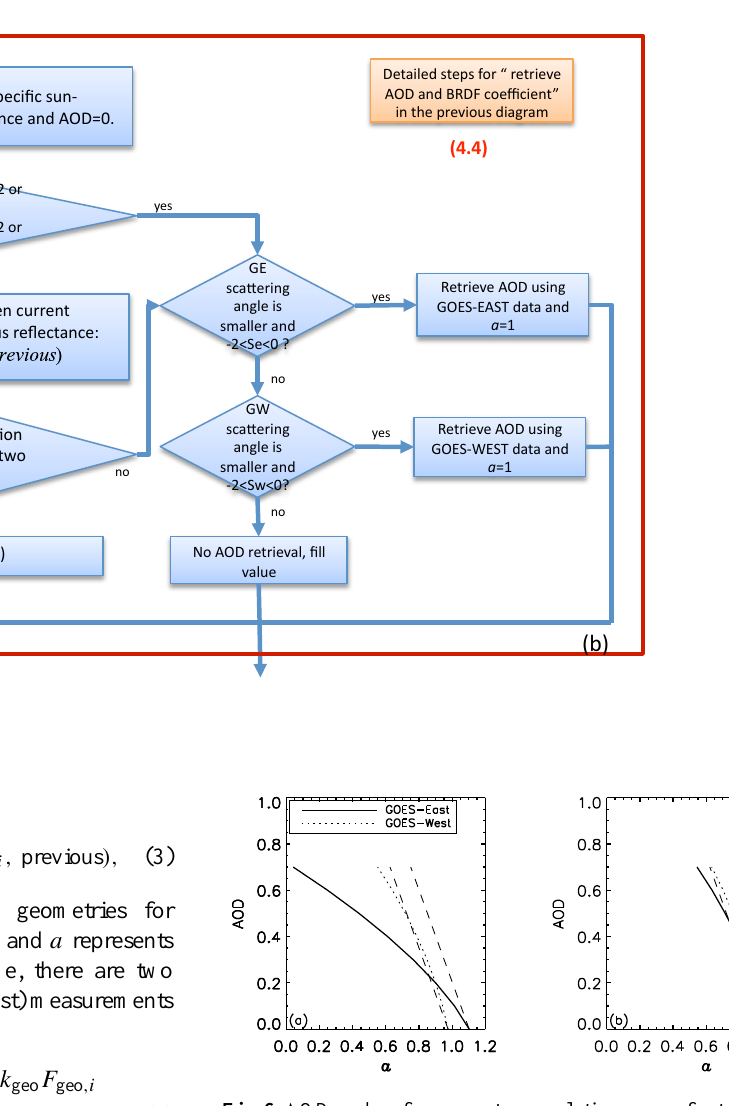
Algorithm flow chart for hybrid GOES‐WEST and GOES‐EAST data Time series of past three days of GOES radiance data from both satellites Cloud mask Retrieve surface reflectance at each Cme step with cosine of sza ≥0.3 and daily AOD <0.3 Filter out surface reflectance with large variaCon (4.2) Number of new inputs > 12? Yes